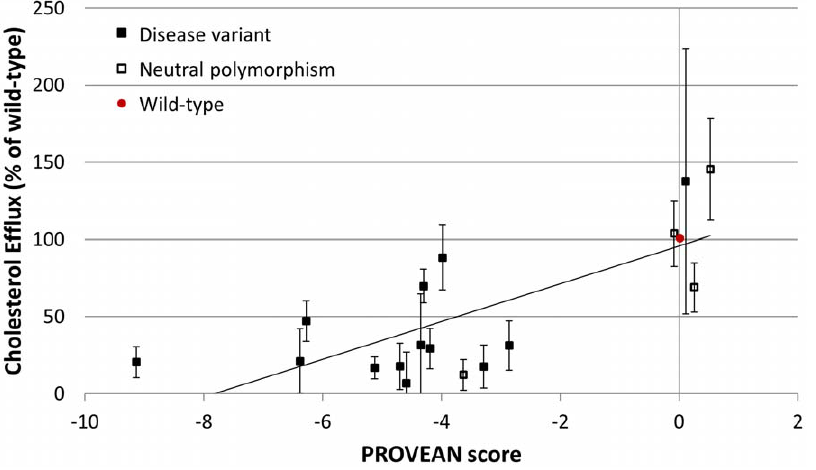
Figure 8. Correlation of cholesterol efflux values with the PROVEAN scores for ABCA1 variations. In general, an increase in score (i.e. less deleterious effects) correlates with an increase in cholesterol efflux